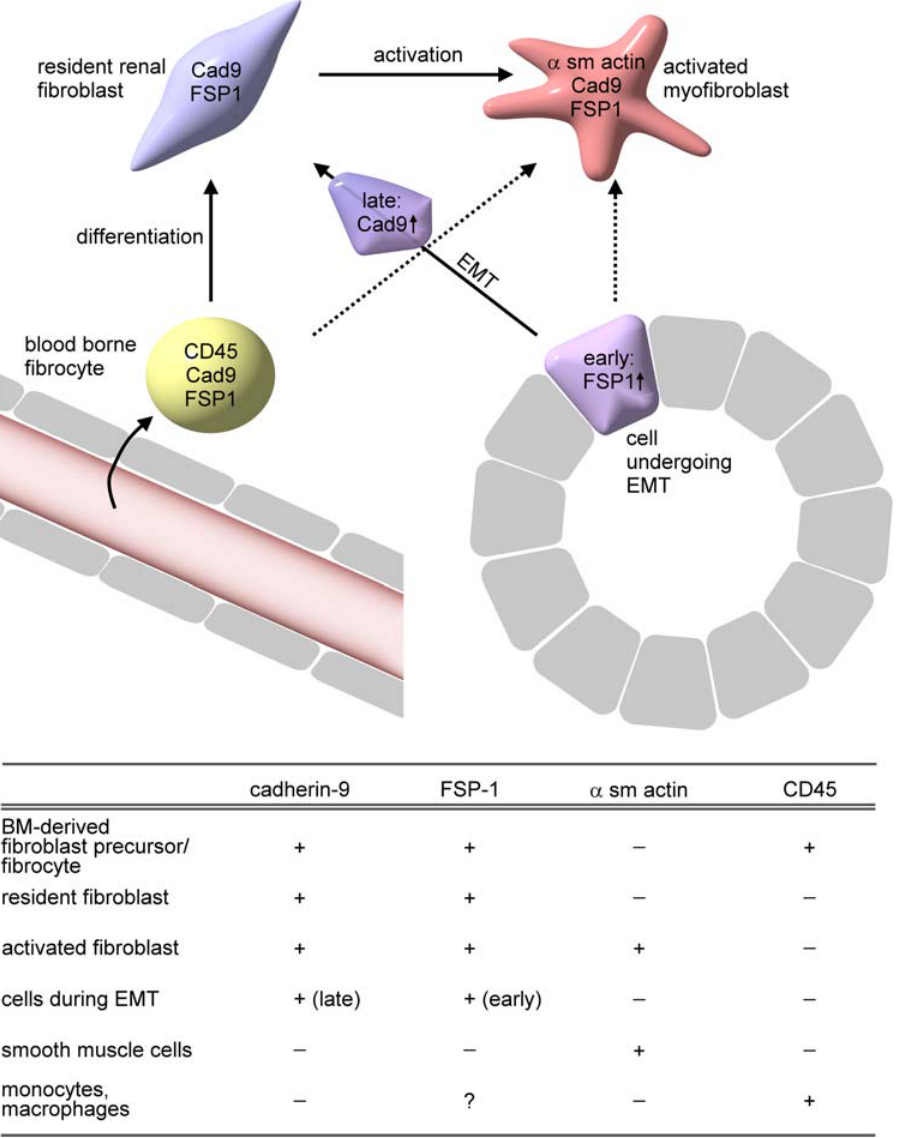
Figure 10. Model of antigen expression in different fibroblast pools, smooth muscle cells and monocytes in the human kidney. Together with FSP1, a -smooth muscle actin ( a sm actin) and CD45, cadherin-9 is a novel cell surface marker, which can be used to differentiate the depicted renal fibroblast subpopulations from other renal cell types such as epithelial and endothelial cells, smooth muscle cells, monocytes or macrophages.